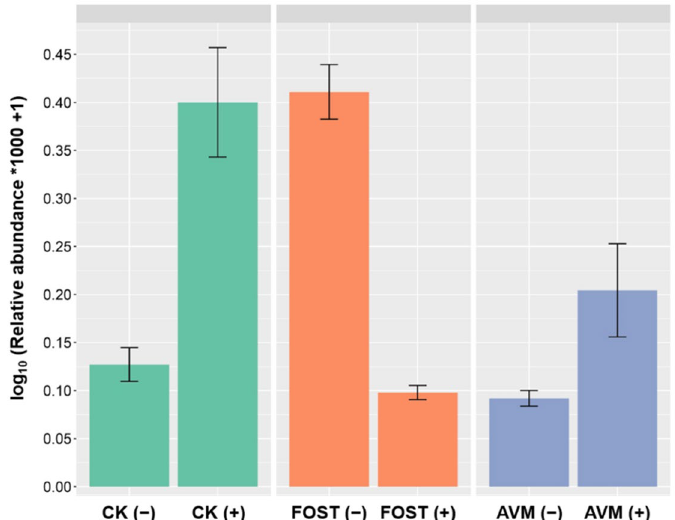
Figure 5. The relative abundance of Burkholderia spp. in different treatments. Error bar and * indicate standard error at P = 0.05 in the ANOVA test for microbial content. CK: control; FOST: fosthiazate; AVM: avermectin. (+ /−) stands for with and without B418